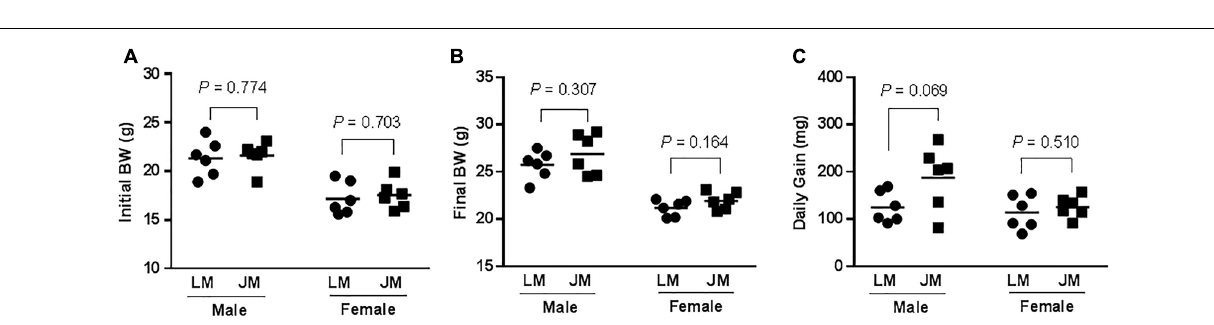
FIGURE 7 | Initial (A) and final body weight (BW) (B) and daily weight gain (C) of mice receiving fecal microbiota of Landrace and Jinhua pigs. The horizontal line in each group denotes the average value of six mice. JM, mice receiving fecal microbiota from Jinhua pigs; LM, mice receiving fecal microbiota from Landrace pigs. Statistical analysis was conducted using unpaired Student’s t -test and the significance values were